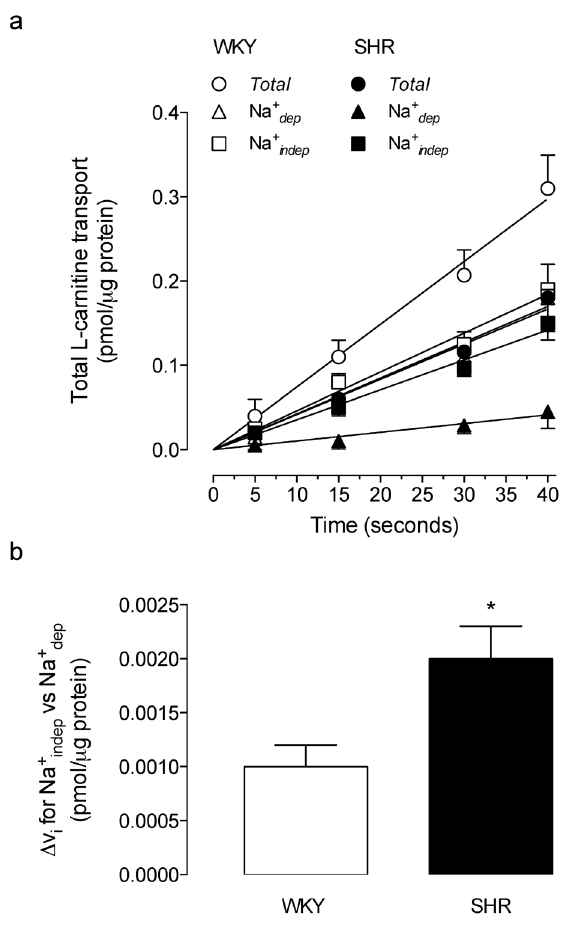
Figure 2. Initial velocities for total transport of L-carnitine. (a) Initial velocity ( n i ) for total transport of L-carnitine ( Total ), and the Na + - dependent (Na + dep ) and Na + -independent (Na + indep ) transport compo- nents (20 m mol/L L-carnitine, 3 m Ci/mL L-[ 3 H]carnitine, 37 u C) in RAECs cultured from WKY rats or SHR. (b) Difference between the v i ( D v i ) for Na + indep and Na + dep components of transport in WKY rats or SHR. * P , 0.05 versus WKY. Values are mean 6 SEM (n=15).